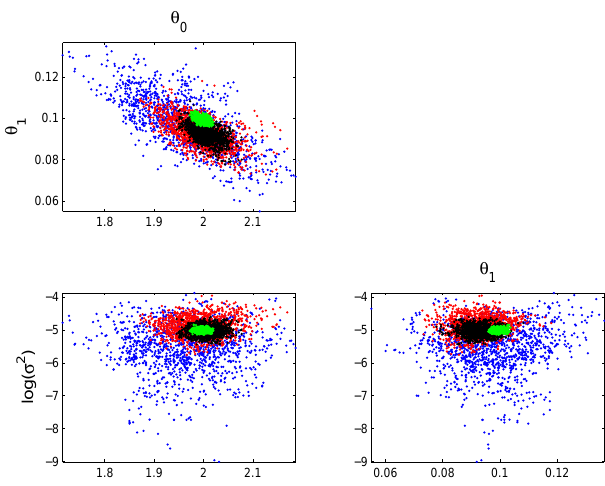
Fig. 4. Scattering plot of parameter pairs from MCMC runs us- ing 10 (blue), 20 (red), 50 (black) and 500 (green) day simula- tions. Clear tightening of posterior can be observed as the simu- lation length increases. The third parameter is related to the model error covariance.